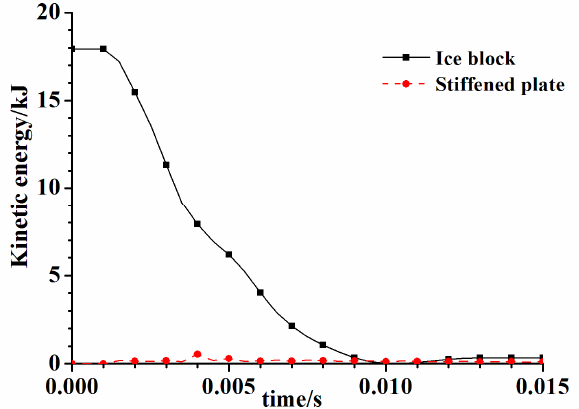
Figure 23. Kinetic energy of the stiffened plate and ice block obtained from simulation.